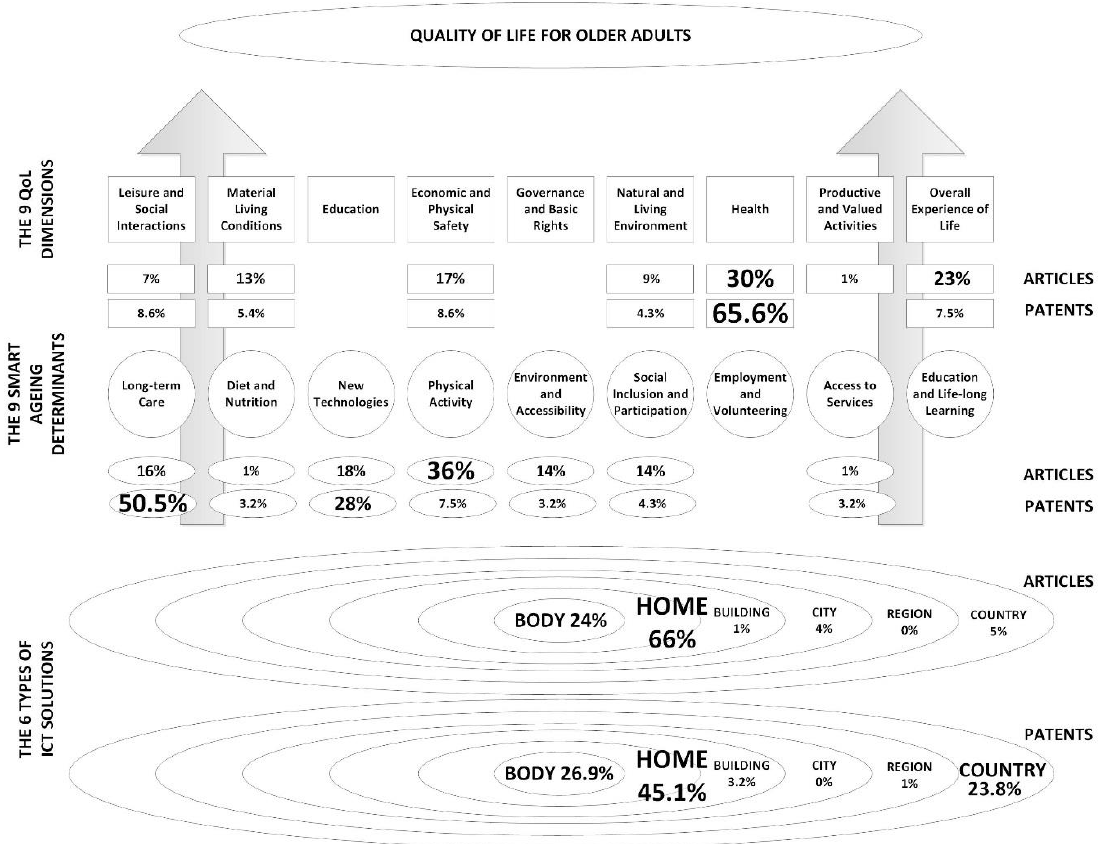
Figure 4. Summary of joint literature and patent analysis results in accordance with the framework on Figure 1.